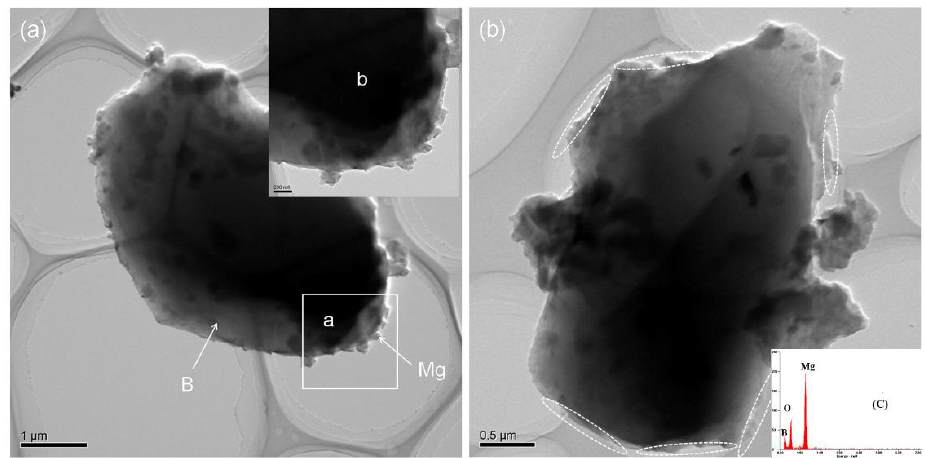
Figure 7. TEM images of ( a ) Mg/B1 cryomilled for 6 h, ( b ) and Mg/B1 cryomilled for 9 h. During cryomilling process, the compound mechanism of Mg/B1 powder was divided into several continuous stages as shown in Figure 8. First, B particles and Mg particles (marked as B and Mg in Figure 8) are severely deformed, B particles tend to become smaller with holes and pits on the surface while Mg particles present a small smooth flake morphology. Then, Mg particles are crafted into smaller particles due to the shear strength between Mg particles and B particles or Mg and milling balls [26]. When the small Mg particles meet the hole and pits of B particles, it is easy for Mg particles embedded in B particles. With the shear and strike impact during the milling process, Mg particles are uniformly distributed on the surface of B particles.